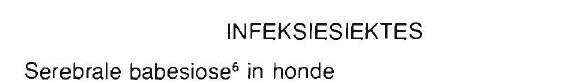
Stootsiekte 21 (Matricaria nigellaefolia) Die etiologie, simptome en ander aspekte van die vergiftiging is reeds in 'n pragtige stuk werk deur An drews! so vroeg as 1923 gepubliseer. Die simptome kon egter nooit verklaar word nie omdat geen patologiese ondersoeke van die brein ooit gedoen was nie. Met onlangse eksperimentele werk te Onderstepoort is ge vind dat daar mikrokavitasie van sekere kerne in die middebrein, breinstam en serebellum voorkom, asook 'n uitgesproke perivaskulere gliose dwarsdeur die sen trale senustelsel. Hierdie letsels kan dus nou gebruik word om hierdie siekte met sekerheid te diagnoseer.